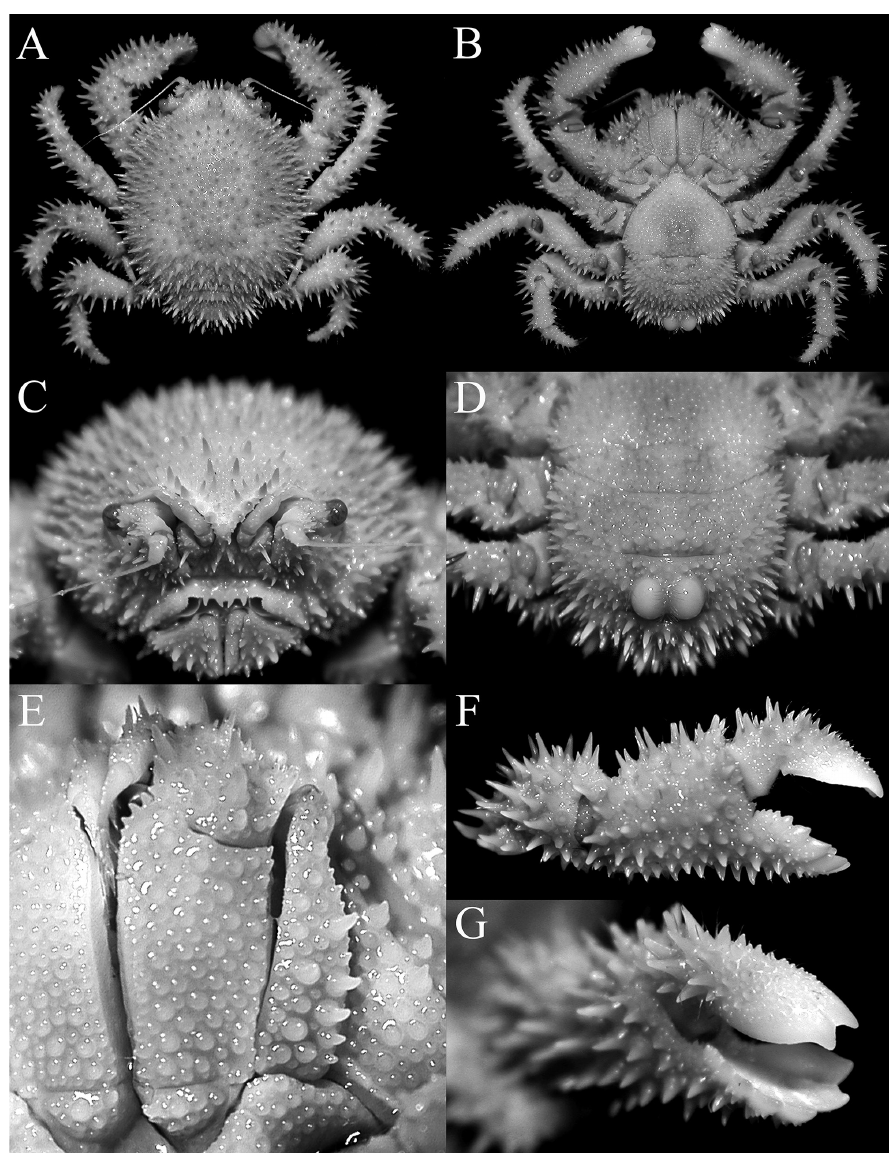
Figure 2. Acanthodromia margarita (Alcock, 1899), female (17.8 × 18.3 mm) (ASIZ 75484), Taiwan. A overall dorsal view B ventral view of cephalothorax C frontal view of cephalothorax D pleon showing tubercles on somite 4 E outer view of left third maxilliped F outer view of right chela G sublateral view of fingers of right